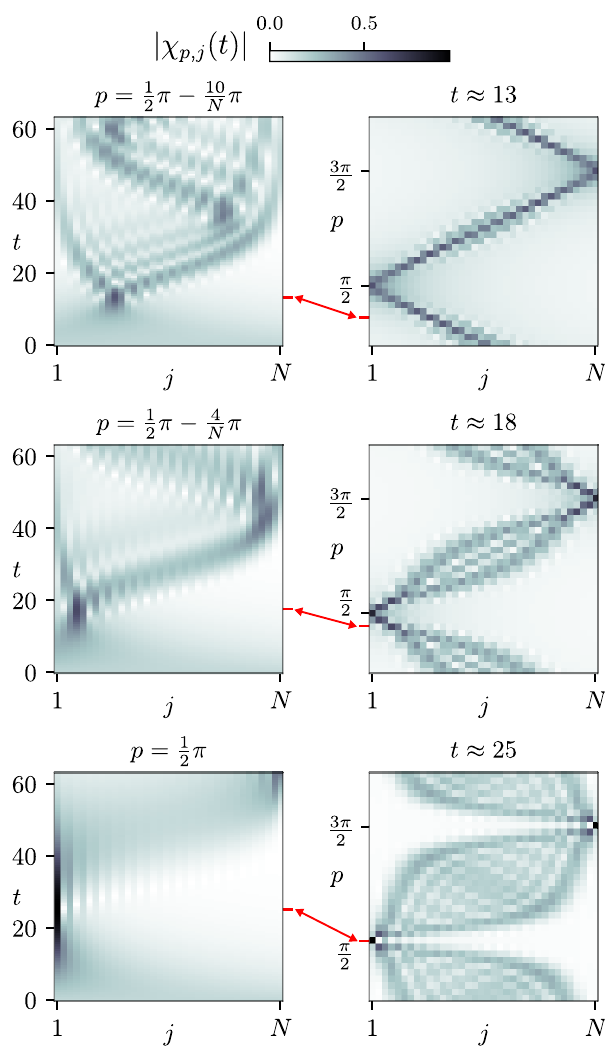
(cid:27) (cid:27) (cid:27) χ (cid:27) ( t ) , Eq. p , j